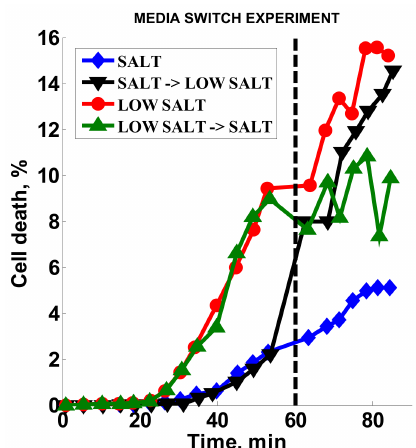
Figure 5. Media salt content effect. Dashed line is the media switch time point. SALT = high-salt media (MHS); LOW SALT = low-salt media (MH); SALT → LOW SALT = switch from high-salt to low-salt media (MHS → MH); LOW SALT → SALT = switch from low-salt to high-salt media (MH → MHS).